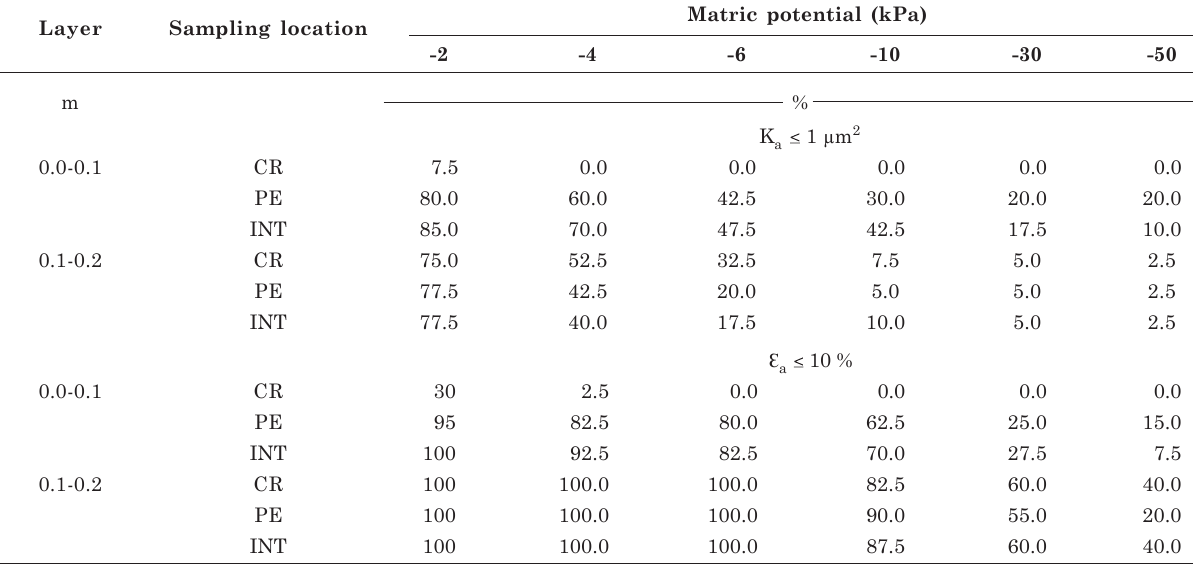
Table 4. Percentage of soil samples with air permeability (K a 1 µµµµµ m 2 ) and air-filled porosity ( Ɛ a 10 %) below the critical values at the sampling locations crop row (CR), interrow (INT) and the equidistant point between CR and INT (PE), in the 0.0-0.1 and 0.1-0.2 m layers, at different matric